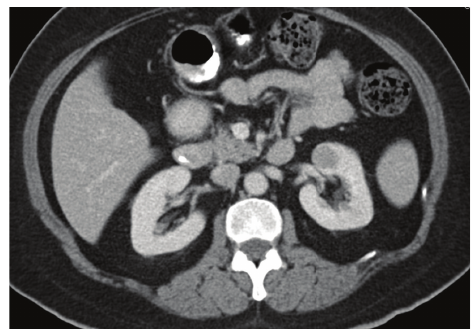
Figure3:Contrast-enhancedCTshowingawell-definedhypodense mass at the anterior midpole of the left